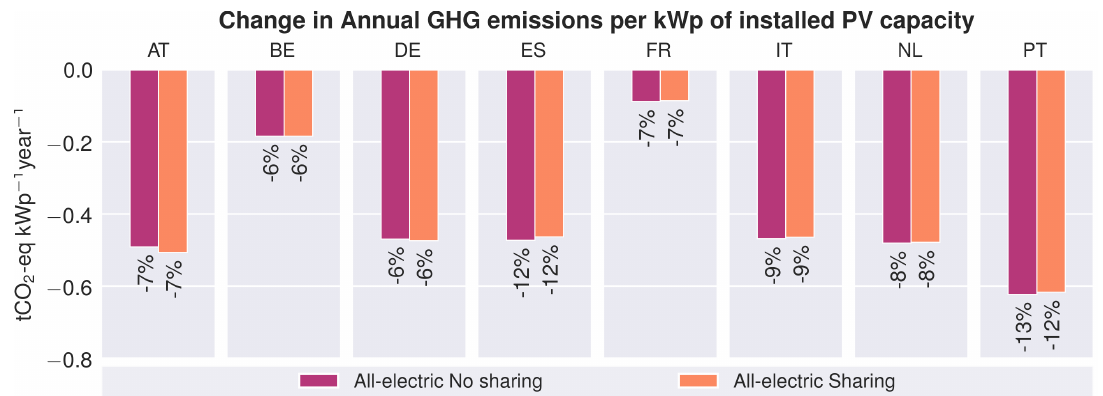
Figure 8. Greenhouse gas emission reduction potentials for PV systems in the eight selected countries. Data are shown as the change in annual emissions related to electricity supply, expressed per kWp of installed PV system capacity. The data presented includes both reductions due to reduced electricity consumption, as well as due to feed-in of PV electricity to the grid. The percentages shown indicate the average relative reduction per kWp per building in the